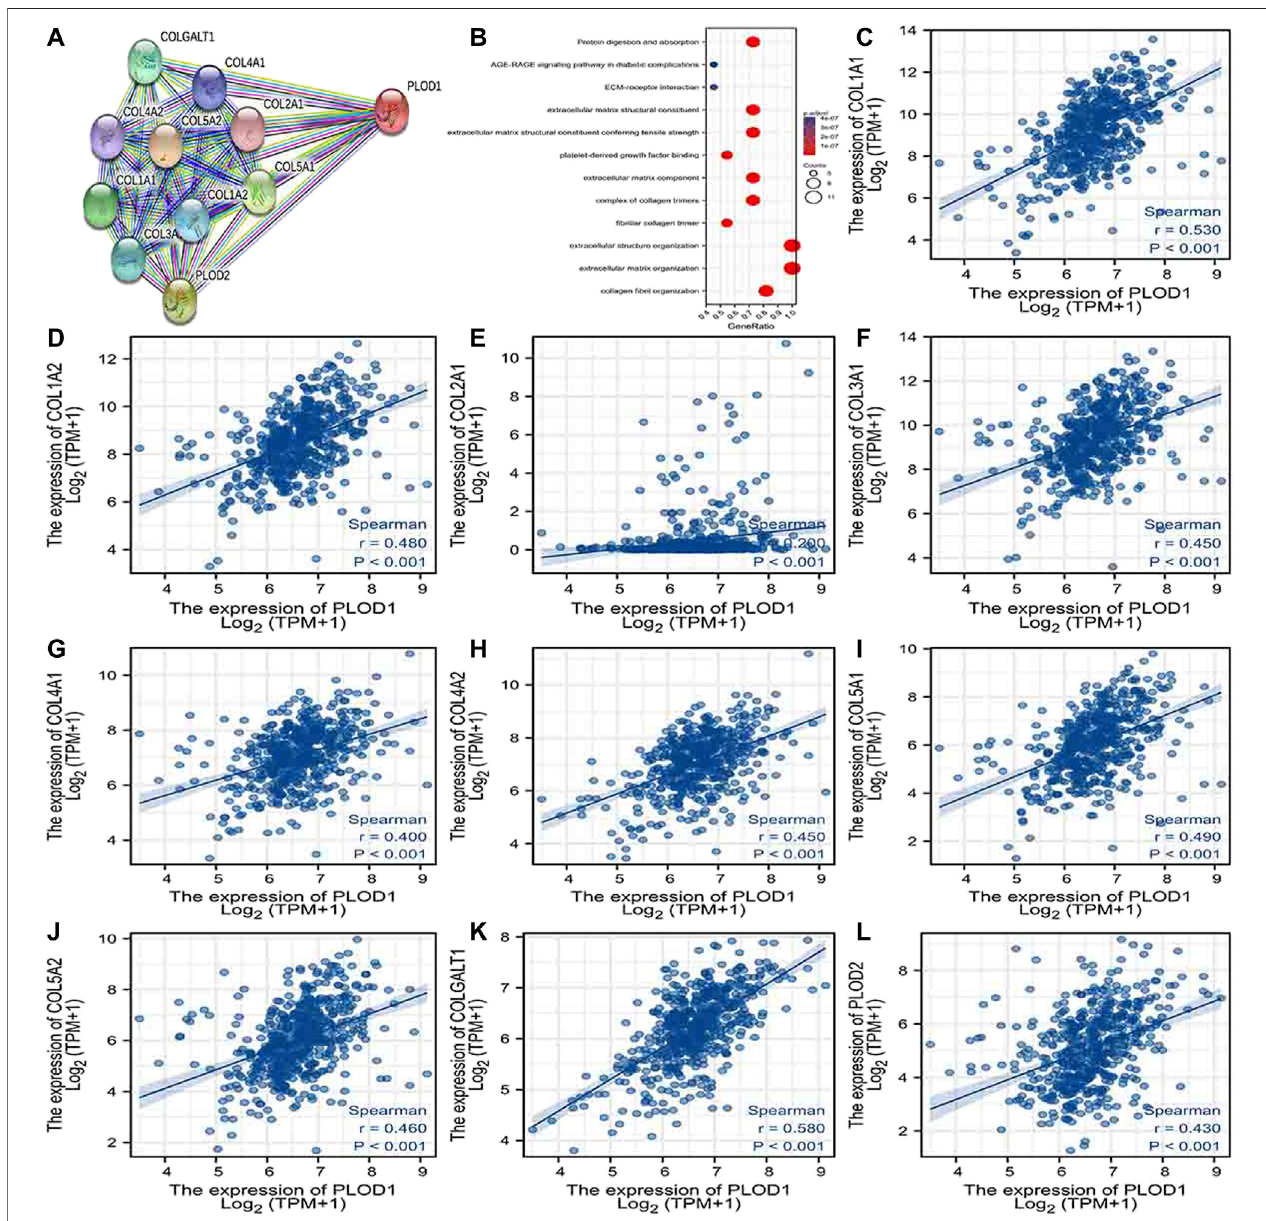
FIGURE 6 | PLOD1 PPI network and biological function annotation. (A) Network of PLOD1 and its co-expressed genes. (B) Functional enrichment analysis of 10 networkgenes.PLOD1isassociatedwithcollagen fi brilorganization,extracellularmatrixorganization,andextracellularstructuralorganization.Thesegenesareinvolved in protein digestion and absorption, ECM – receptor interactions, and the AGE-RAGE signaling pathway in diabetic complications. (C – L) Correlations between the expression of PLOD1 and co-expressed genes in LUAD. COL1A1, collagen alpha-1(I) chain; COL1A2, collagen alpha-2(I) chain; COL2A1, collagen alpha-1(II) chain; COL3A1, collagen alpha-1(III) chain; COL4A1, collagen alpha-1(IV) chain; COL4A2, collagen alpha-2(IV) chain; COL5A1, collagen alpha-1(V) chain; COL5A2, collagen alpha-2(V) chain; COLGALT1, procollagen galactosyltransferase 1; PLOD2 : procollagen-lysine,2-oxoglutarate 5-dioxygenase 2.